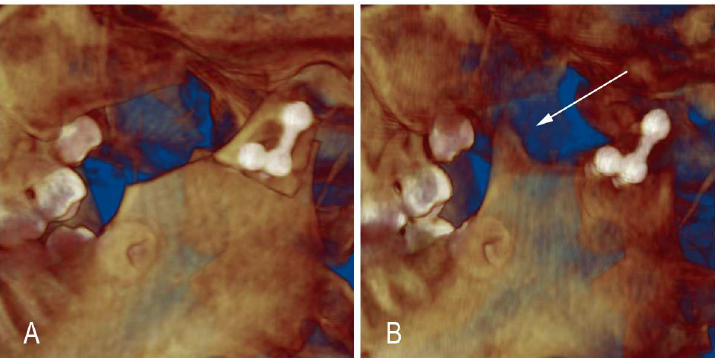
Fig 7. Reduced smaller coronoid regeneration at the former site of the coronoid process resection (white arrow; A: T1 point; B: T2